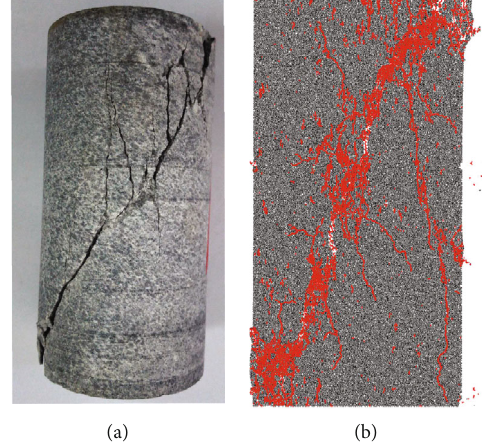
Figure 6: Failure modes of intact sandstone specimens obtained through simulation and experiment: (a) experimental failure mode; (b) numerical failure mode.